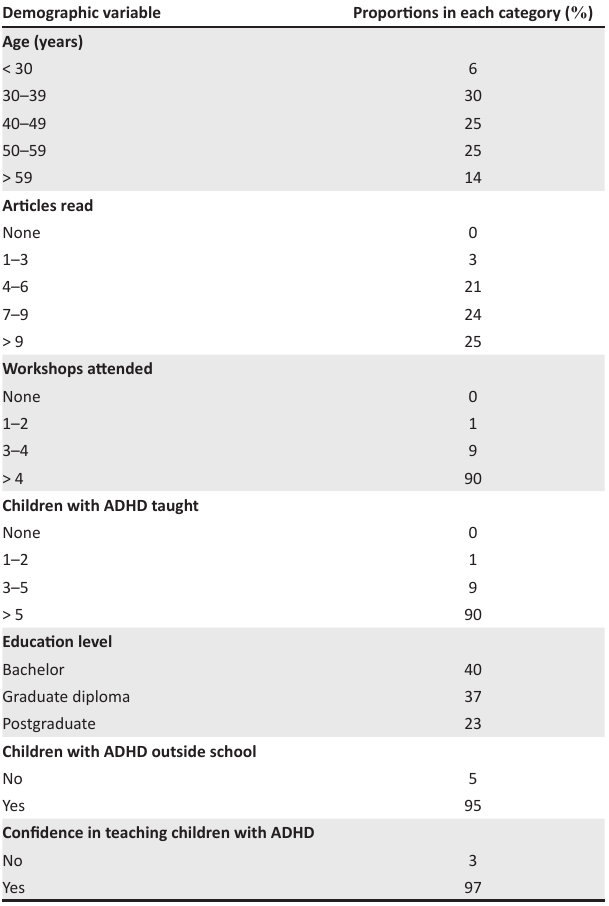
TABLE 1: Proportions in each demographic variable category. Demographic variable Proportions in each category ( %